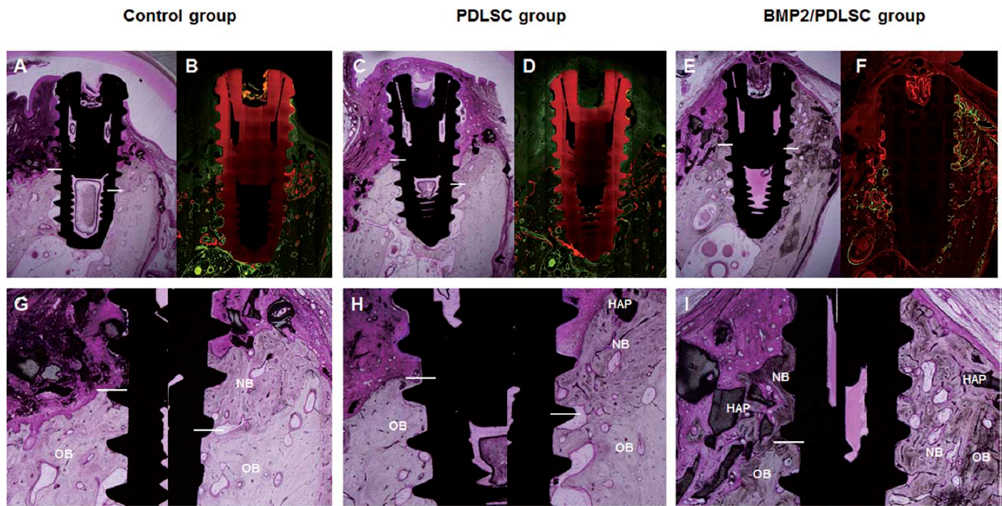
Figure 4. Bone regeneration and re-osseointegration around peri-implantitis defects by AdBMP-2/PDLSCs. Upper pannel: light microscopic ( A , C , E ) and confocal laser scanning microscopic ( B , D , F ) photographs of histological sections of each experimental group at 12 weeks (original magnification × 1.5). Lower panel: magnification of newly formed bone and re-osseointegration within defects ( G , H, I; original magnification × 4), NB, new bone; HAP, hydroxyapatite particles; OB, old bone; bone labeling: 4 weeks (green), 8 weeks (orange); multiple stains and undecalcified ground sections; bar indicates bottom of defect. Reproduced with permission from Park et al. [39]. Copyright © 2014 Wiley Periodicals, Inc. Table 3. Ex vivo BMP-2 gene therapy for bone regeneration in oral and facial regions